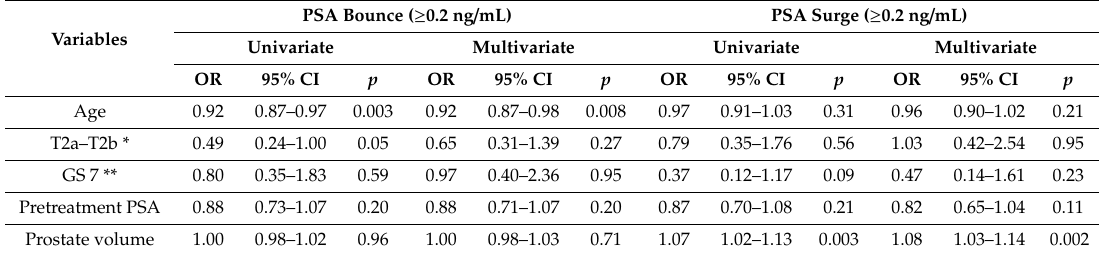
Figure 2. Frequency distribution of PSA bounce, surge, and failure post-CIRT ( n = 131). Table 2. Predictive factors for PSA bounce or surge.